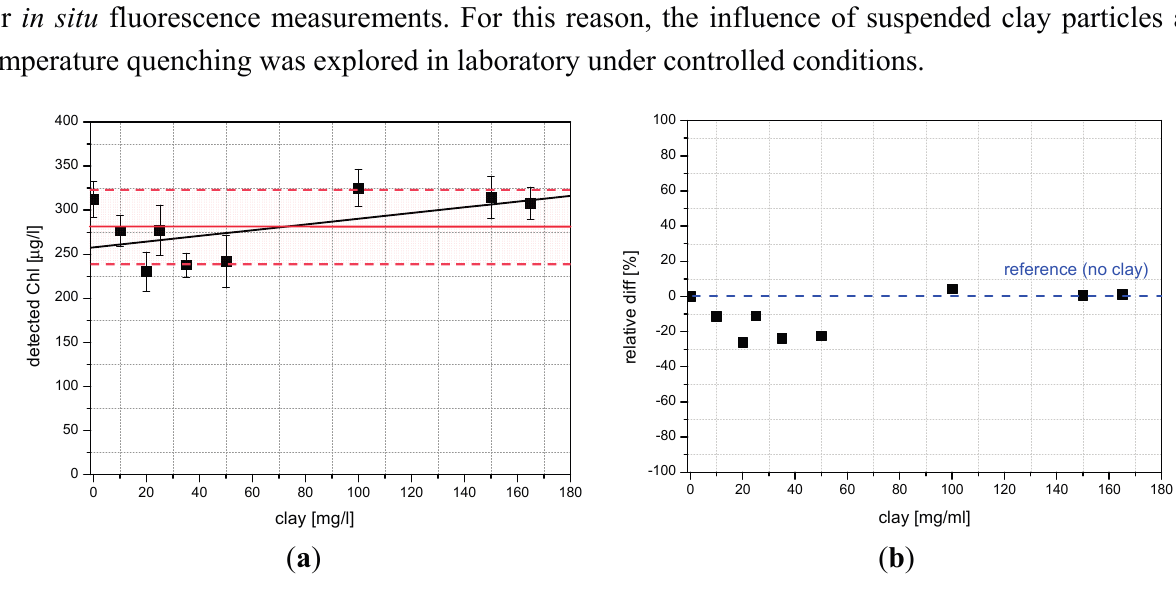
Figure 13. Clay interference on Chl-a detection ( a ); relative differences between the blank (sample without clay) and different turbid samples ( b